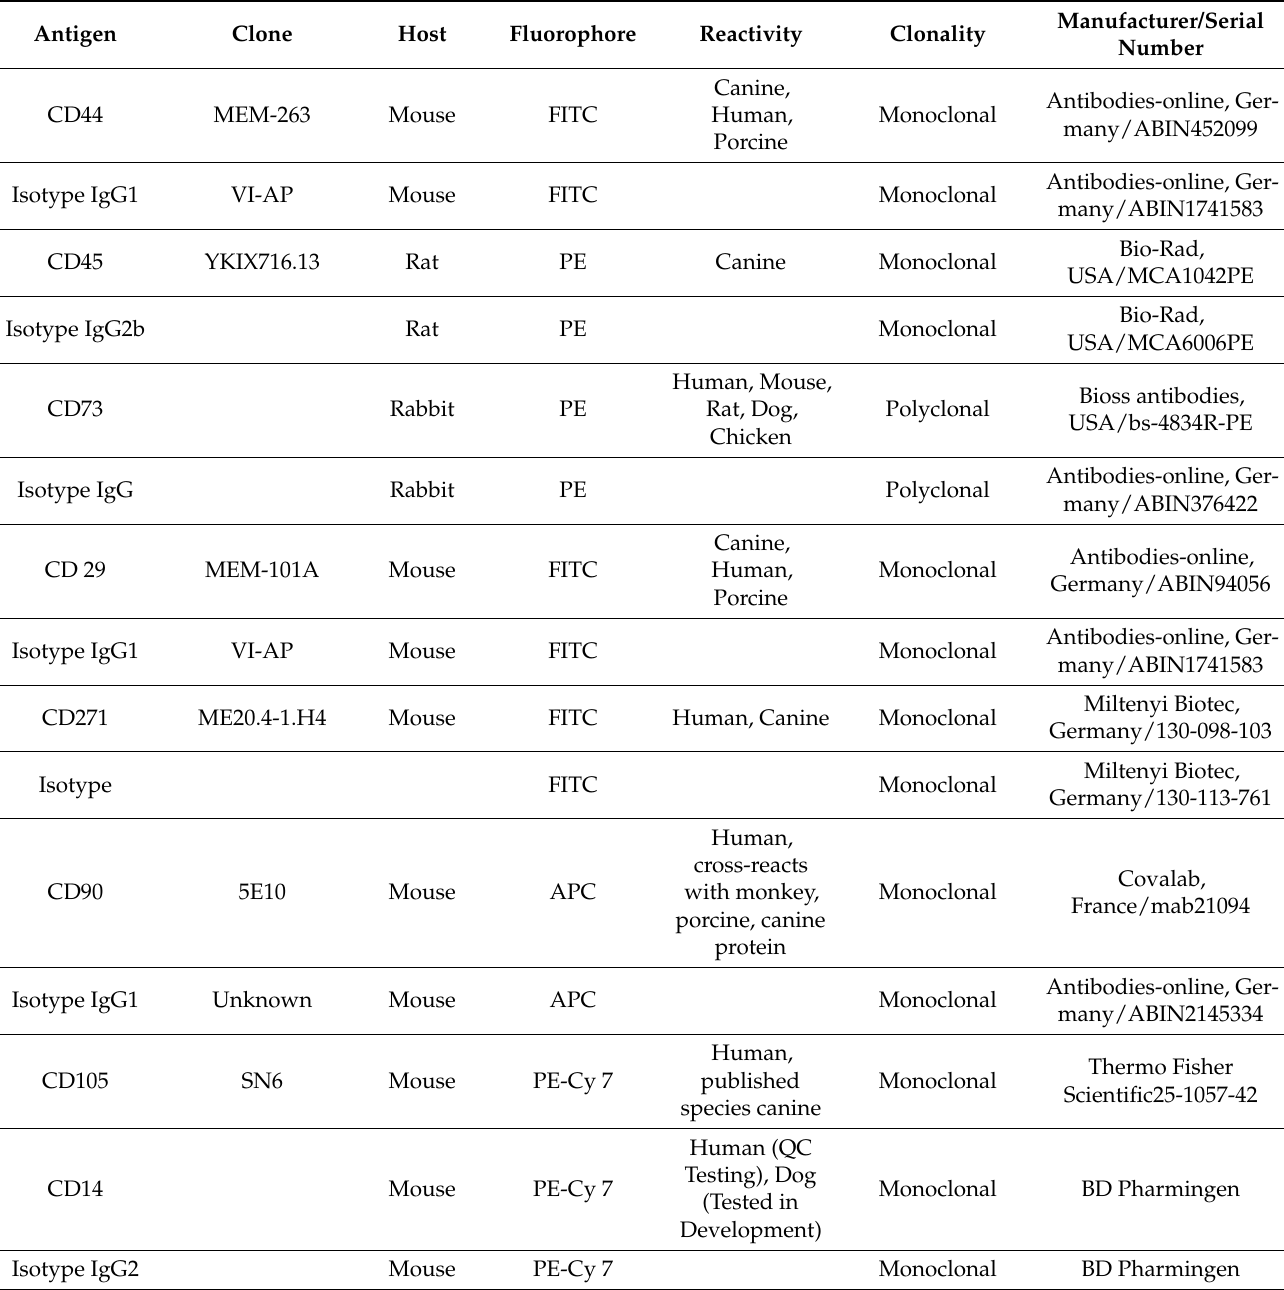
Table 3. Antibody panel created for the